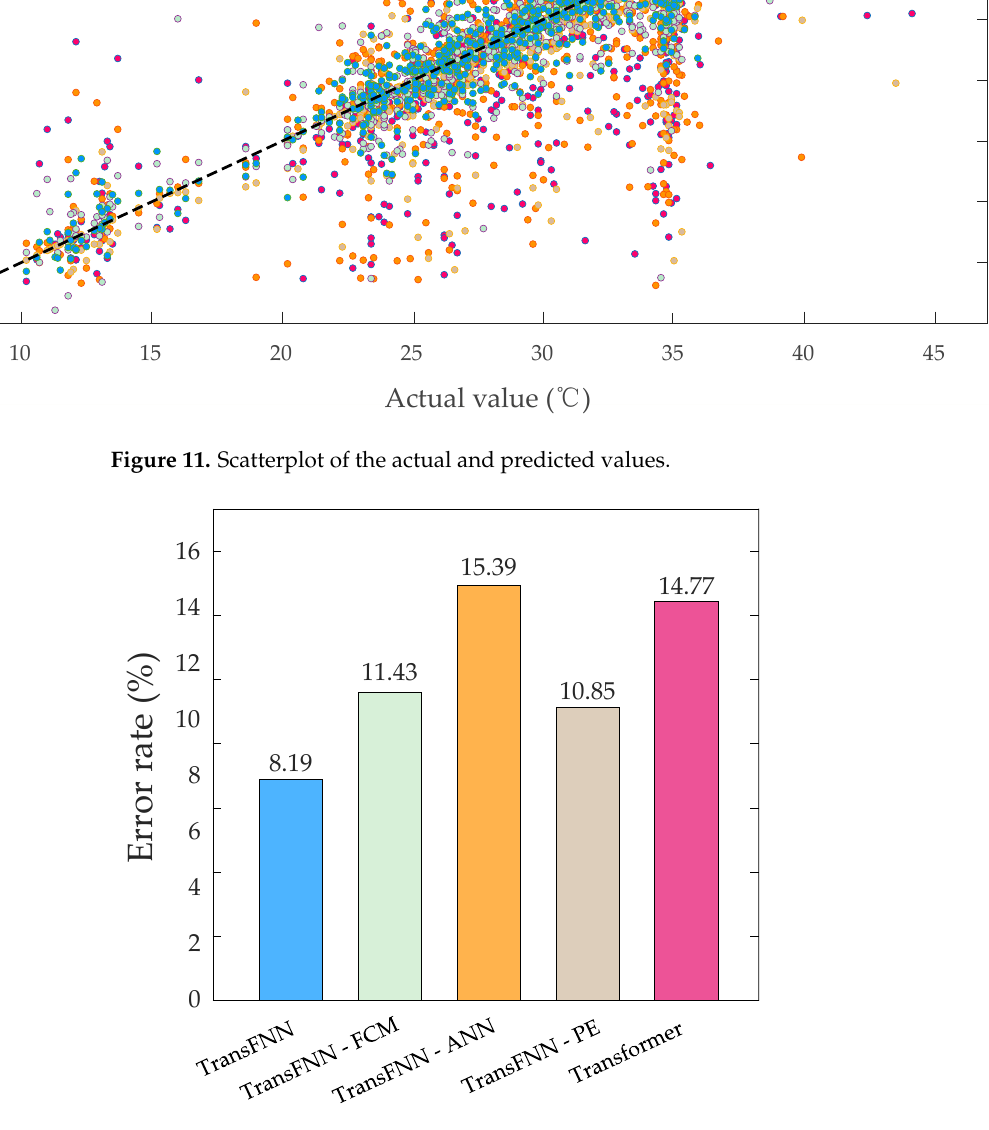
Figure 12. Bar chart of the error rates of the five models.